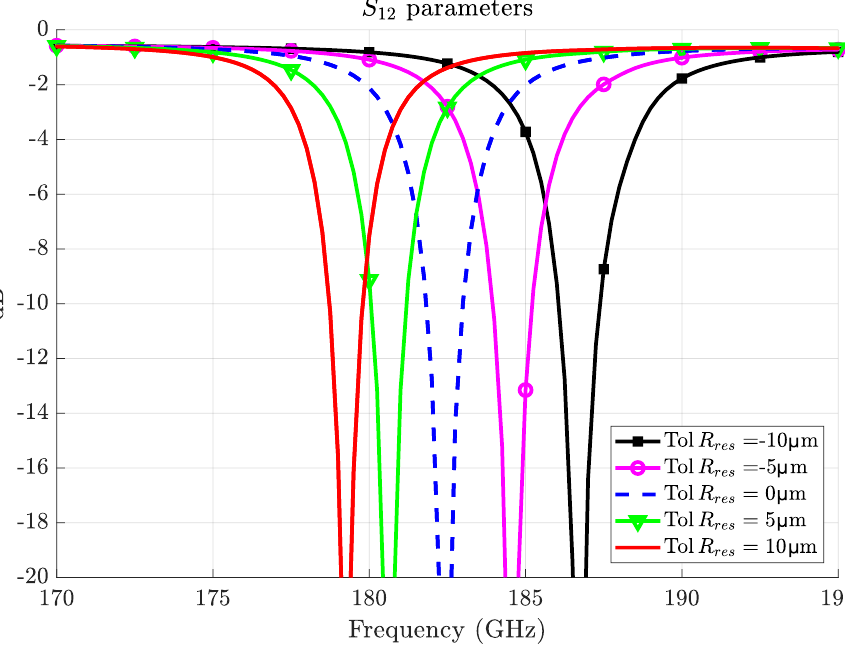
Figure 7. Effect of fabrication tolerances in the resonator radius on resonance